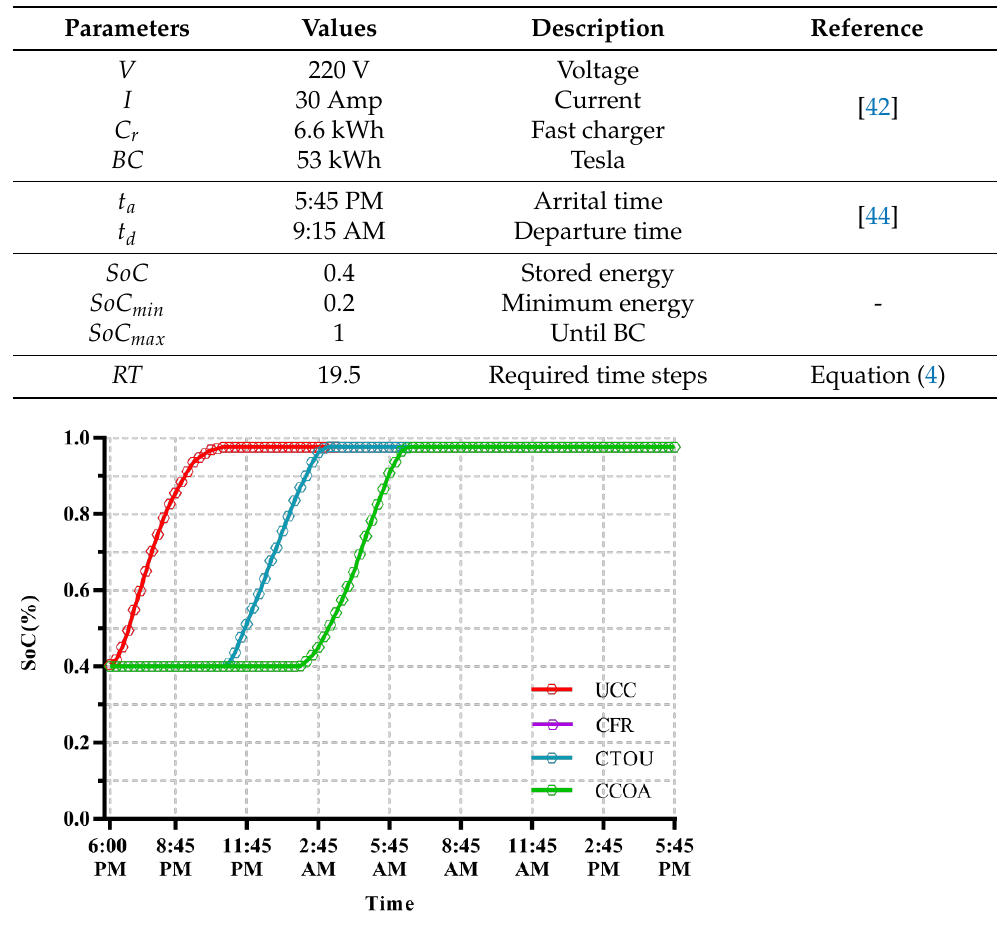
Figure 6. Battery charging process with uncontrolled charging (UCC), coordinated charging based on flat-rate (CFR), coordinated charging based on time-of-use (CTOU), and charging cost optimization algorithm (CCOA).